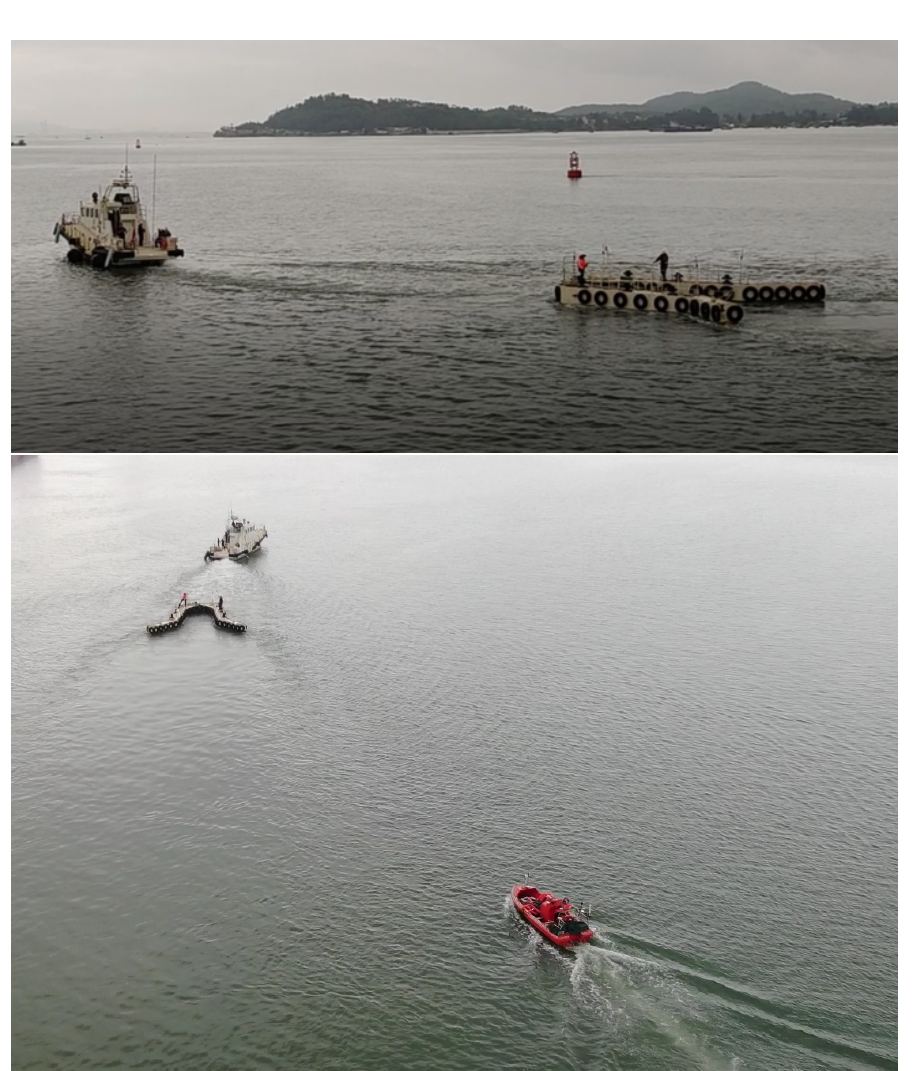
Figure 15. Automatic docking